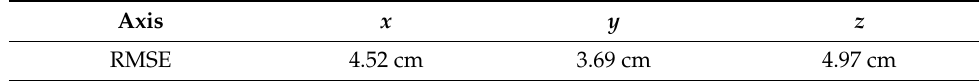
Table 5. Root mean square error (RMSE) of target